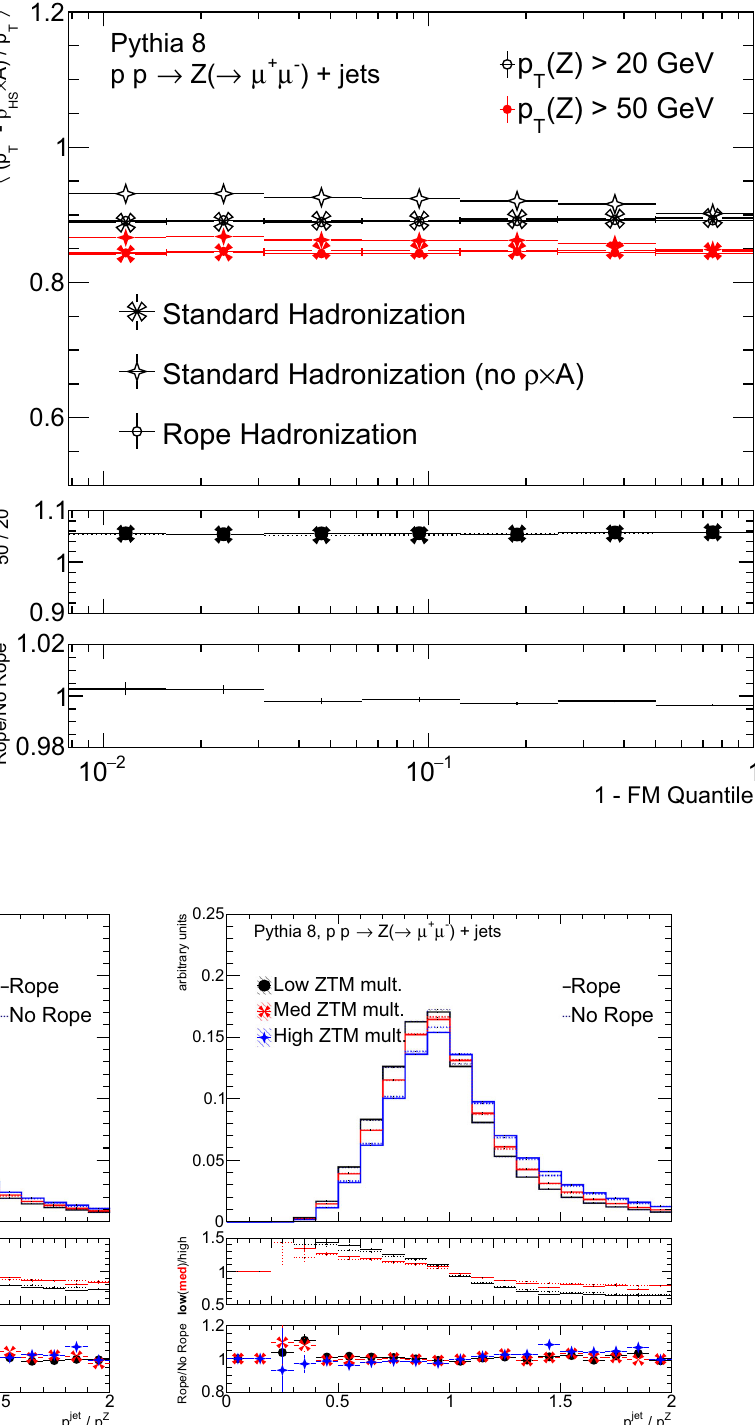
tion with a dotted line). In the lower panel, the ratio between the Rope andstandardhadronizationmodelsisdisplayedforallthreemultiplicity